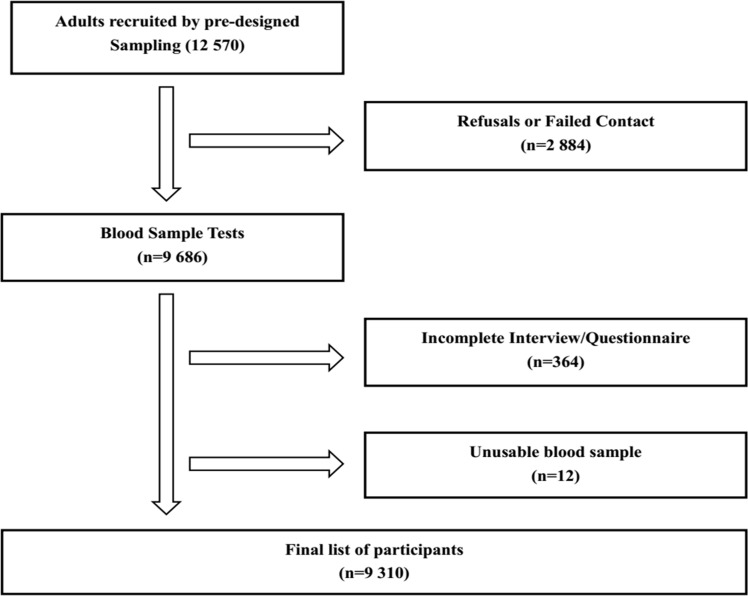
Flow diagram for recruiting subjects.